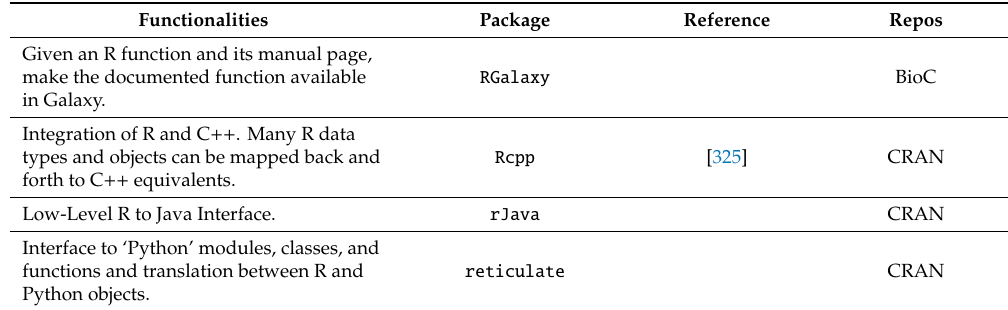
Table 11. Packages to interface R with other languages and workflow environments.